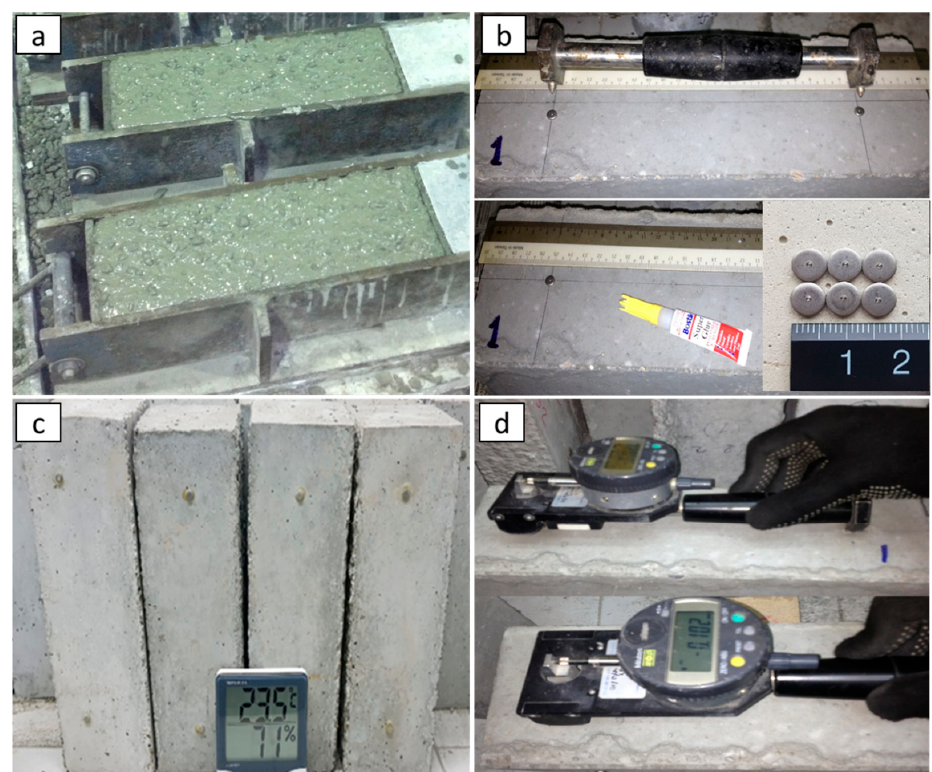
Figure 5. Steps of preparation ( a – d ) for drying shrinkage measurement: ( a ) molding of 100 × 100 × 200 mm concrete prisms; ( b ) bonding of pre-drilled stainless; ( c ) keeping prisms in a drying